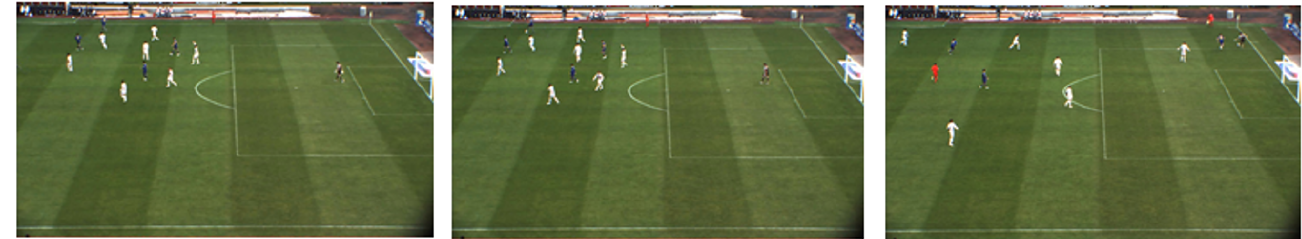
Figure 11. Instances from the ISSIA dataset [277].